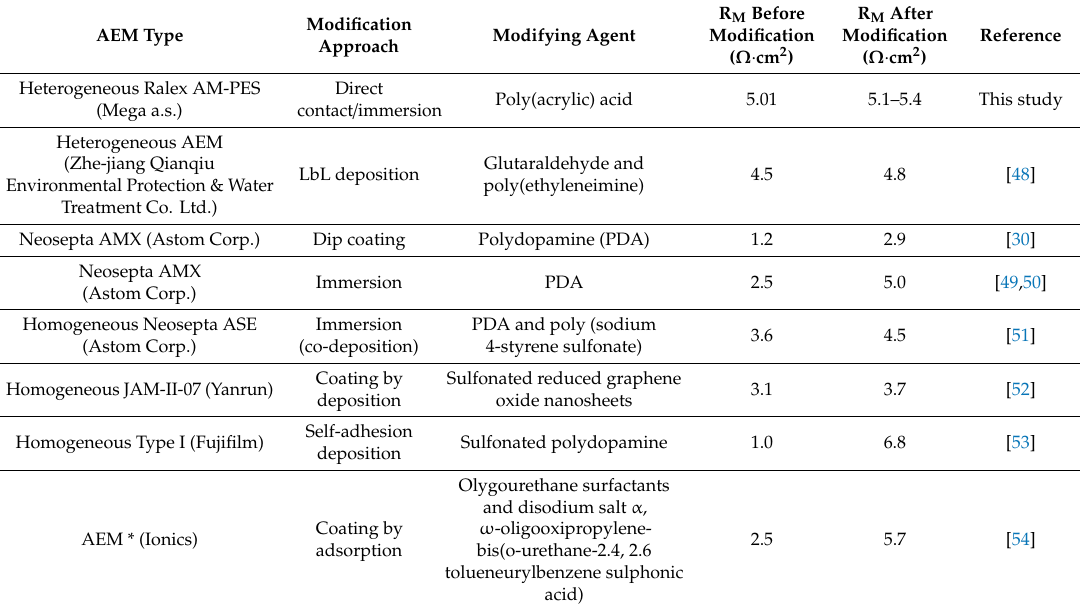
Table 7. Comparison of the membrane resistance values obtained in this study with values reported in literature for other commercial AEMs before and after modification.